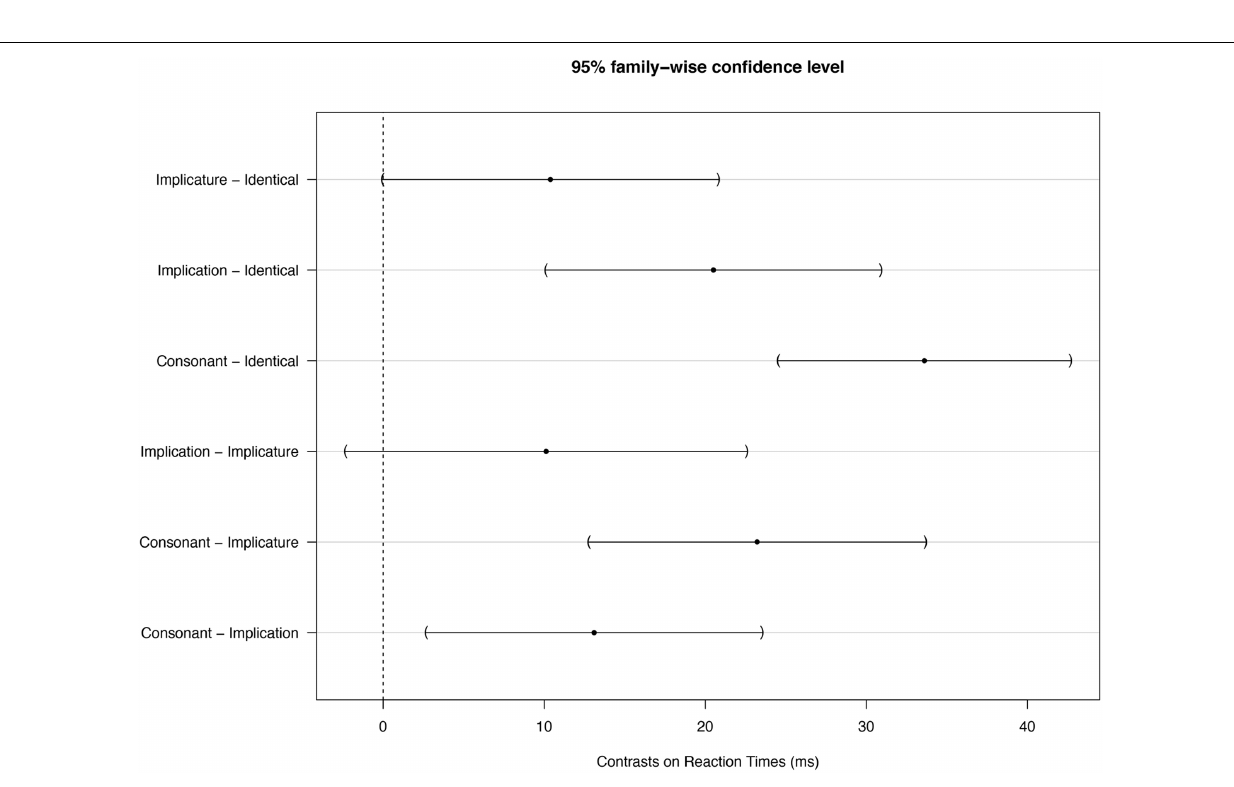
Frontiers in Psychology |